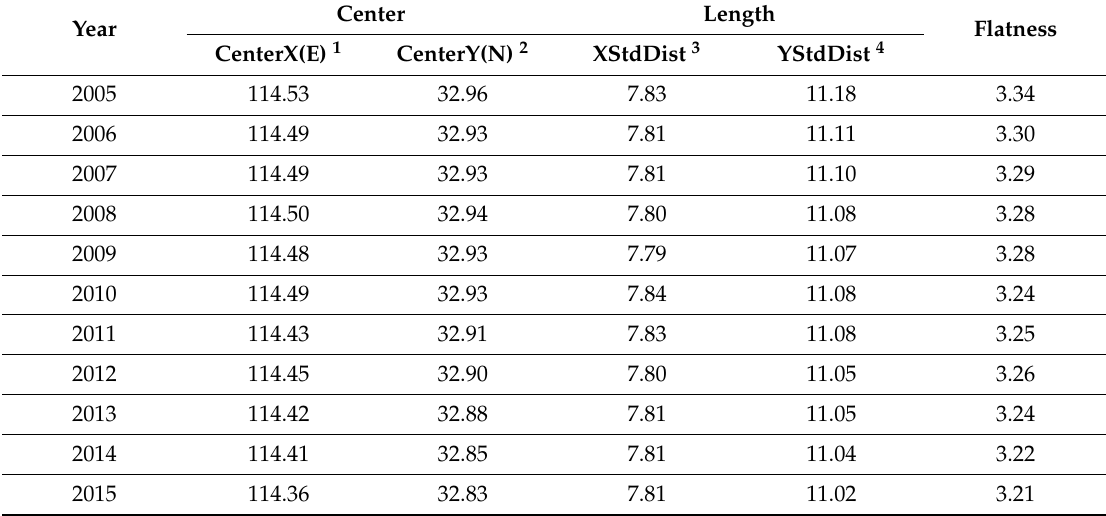
Table 2. Ellipse description parameters of standard deviation of urbanization coordination level from 2005 to 2015.